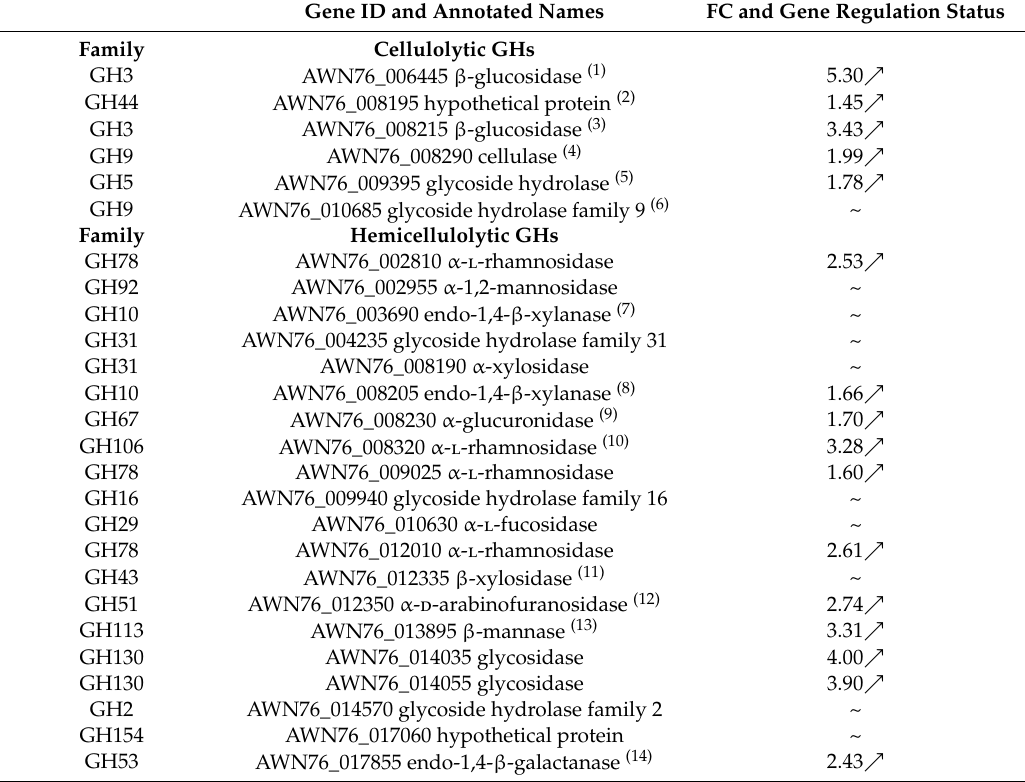
Table 5. Fold change of (hemi-)cellulolytic genes encoded glycosyl hydrolases (GHs). Gene ID and Annotated Names FC and Gene Regulation